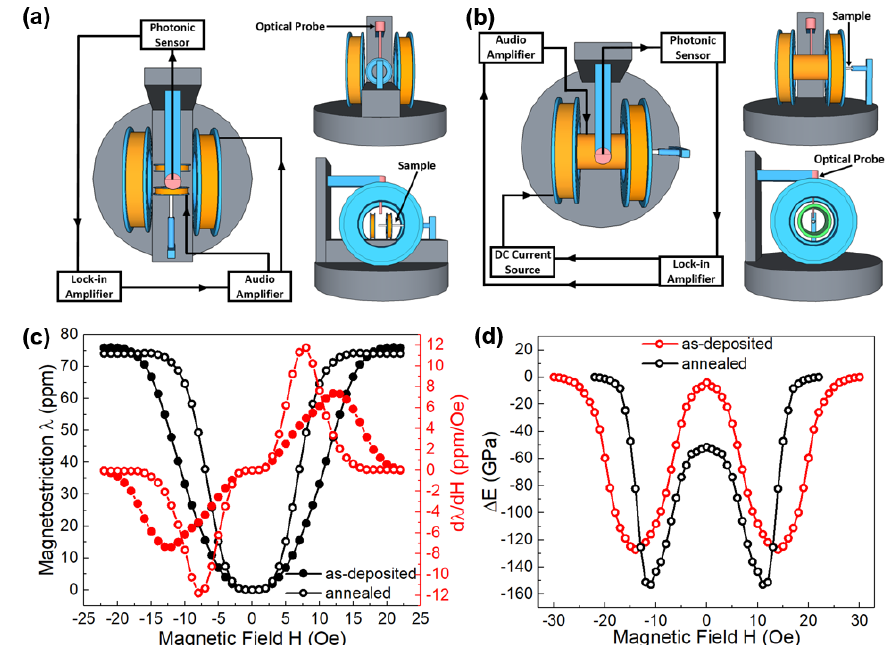
Figure 7. ( a ) Schematic of the proposed magnetostriction tester in three-view. ( b ) Schematic of the proposed delta-E tester in three-view. ( c ) Measured magnetostriction and piezomagnetic coefficient for as-deposited and annealed FeGaB thin films. ( d ) Measured delta-E effect for as-deposited and annealed FeGaB thin films. Reprinted with permission from [66]. Copyright [2018], American Institute of Physics.